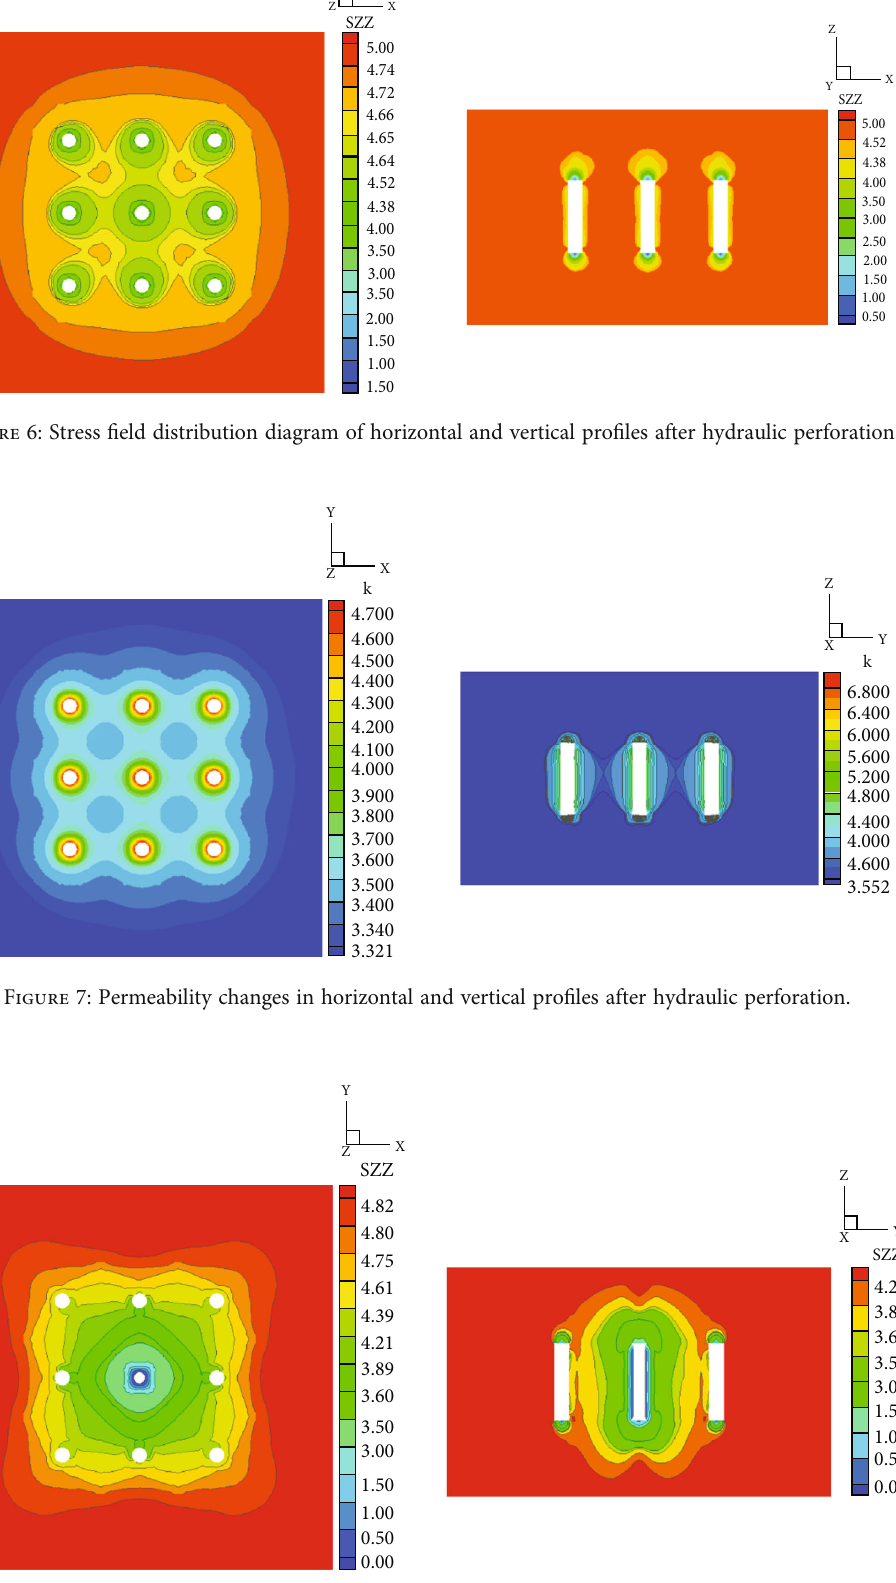
Figure 8: Stress fi eld distribution of the horizontal and vertical pro fi les after hydraulic